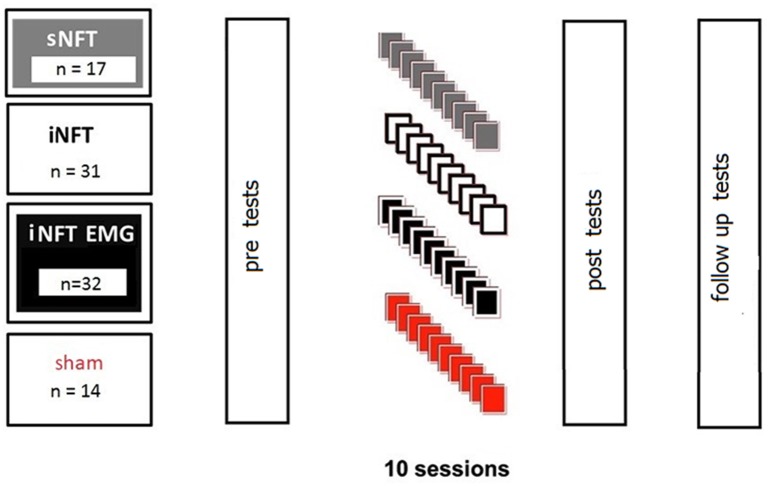
Design of the experiment.